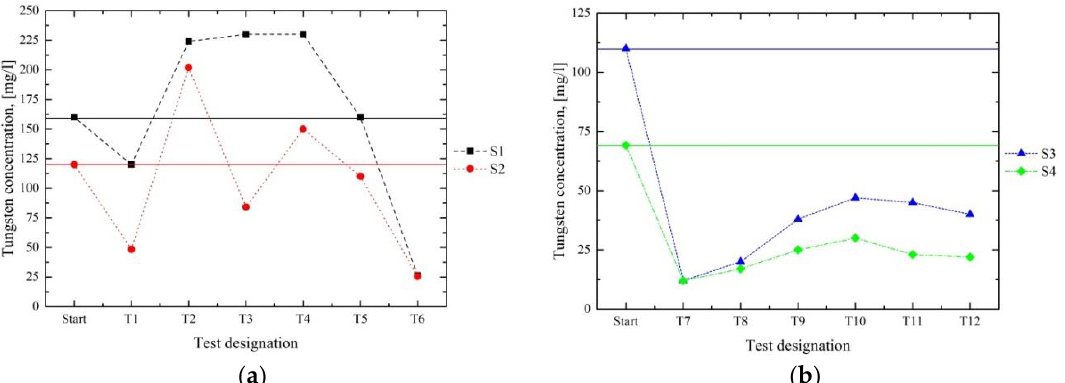
Figure 11. Concentration of tungsten in the initial solutions (start, continuous line) and in the filtrates of series 1 ( a , T1 – T6) and series 2 ( b , T7 – T12) [3].